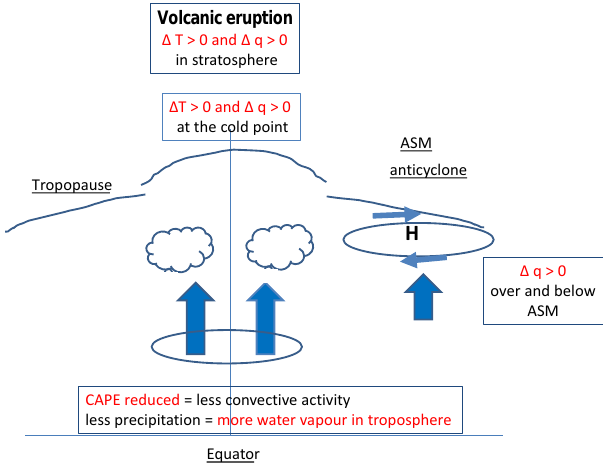
Figure 13. Schematic of tropospheric processes influenced by a strong volcanic